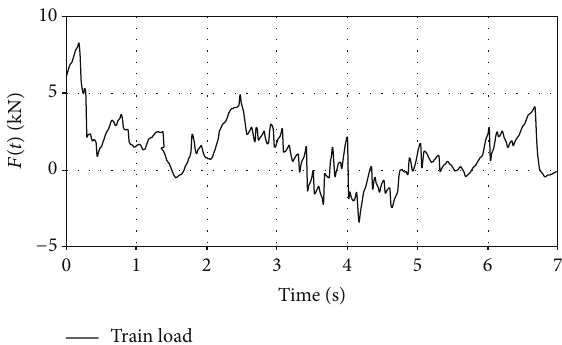
Figure 3: Subway train vibration load